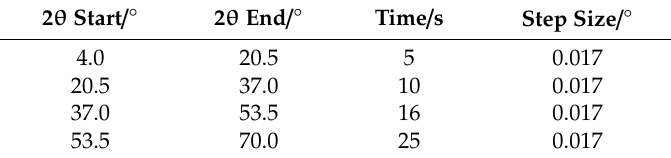
Table 1. The variable-counting time scheme used for the data collection on sample FUR:URE.